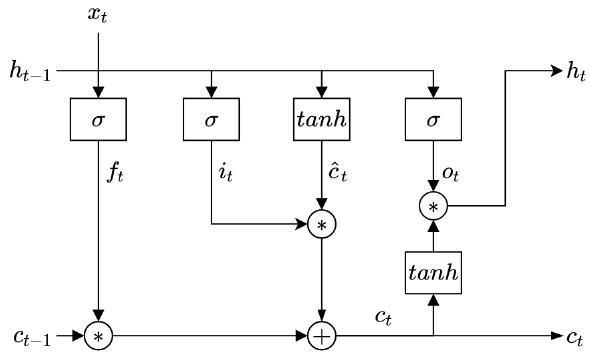
Figure 14. Representation of the LSTM